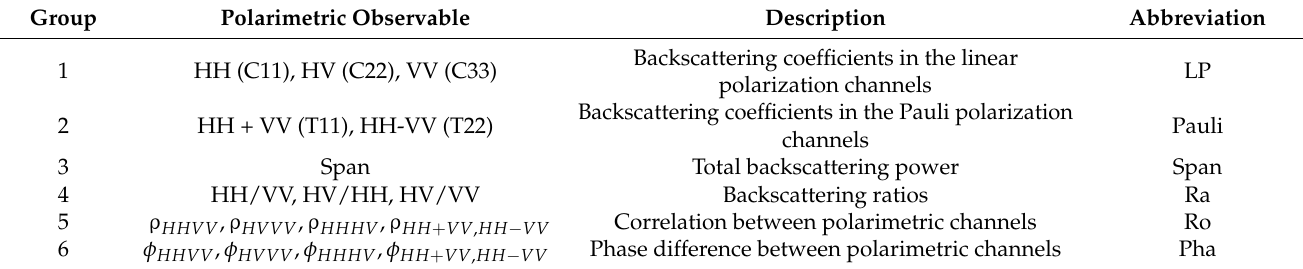
Table 3. The list of 27 polarimetric observables in 10 groups selected for temporal evolutions and classification in this study. Group